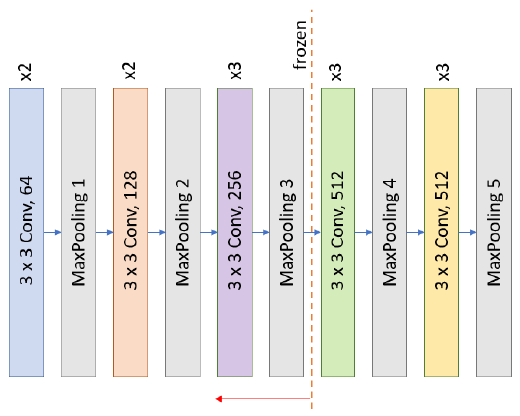
Figure 7. Feature extraction network architecture of the CNN distance model.